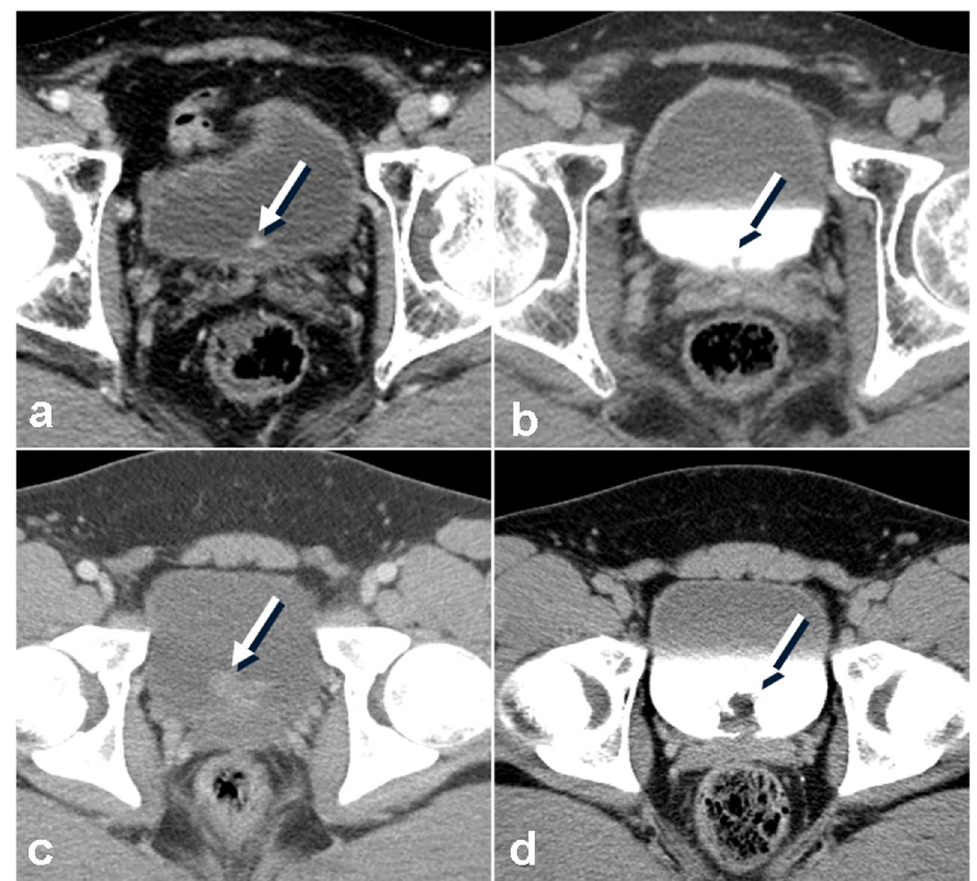
Fig. 8 Two cases of bladder papilloma and papillary urothelial neoplasm of low malignant potential (PUNLMP). Axial urothelial phase a CT image of a 60‑year‑old male patient with bladder papilloma showing a tiny enhancing lesion (arrow) on the trigone of the bladder and also demonstrating a filling defect (arrow) on the excretory phase ( b ) CT image. Axial urothelial phase c of a 19‑year‑old male patient with PUNLMP and excretory phase ( d ) CT images showing an irregular polypoid enhancing lesion and filling defect (arrows) in the bladder mimicking bladder